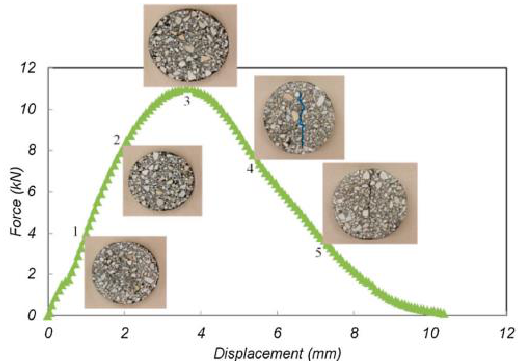
Figure 4. IDEAL cracking test load-displacement curve.